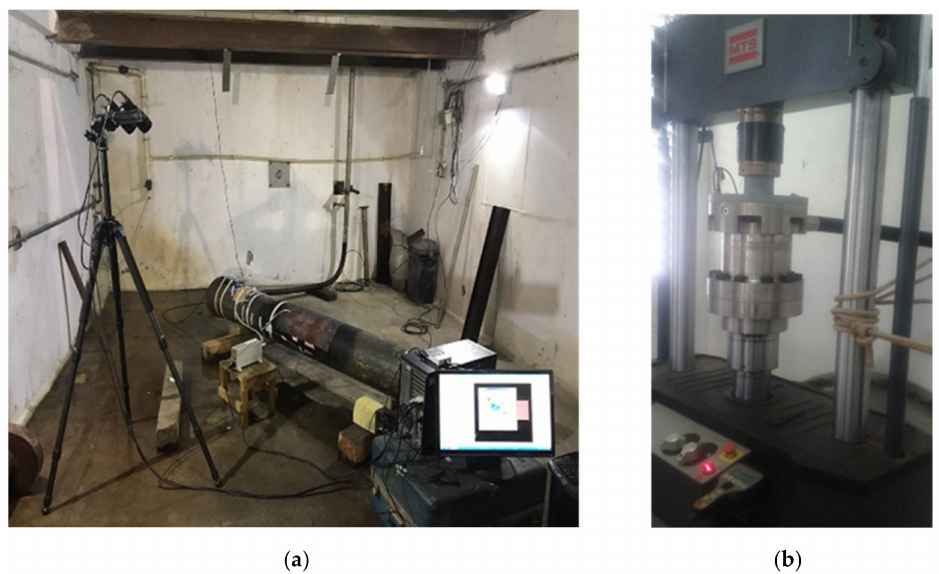
Figure 2. Experimental setup used for in-lab (in-air) investigation: ( a ) specimens and DIC cameras configuration, ( b ) servo-hydraulic test machine used.